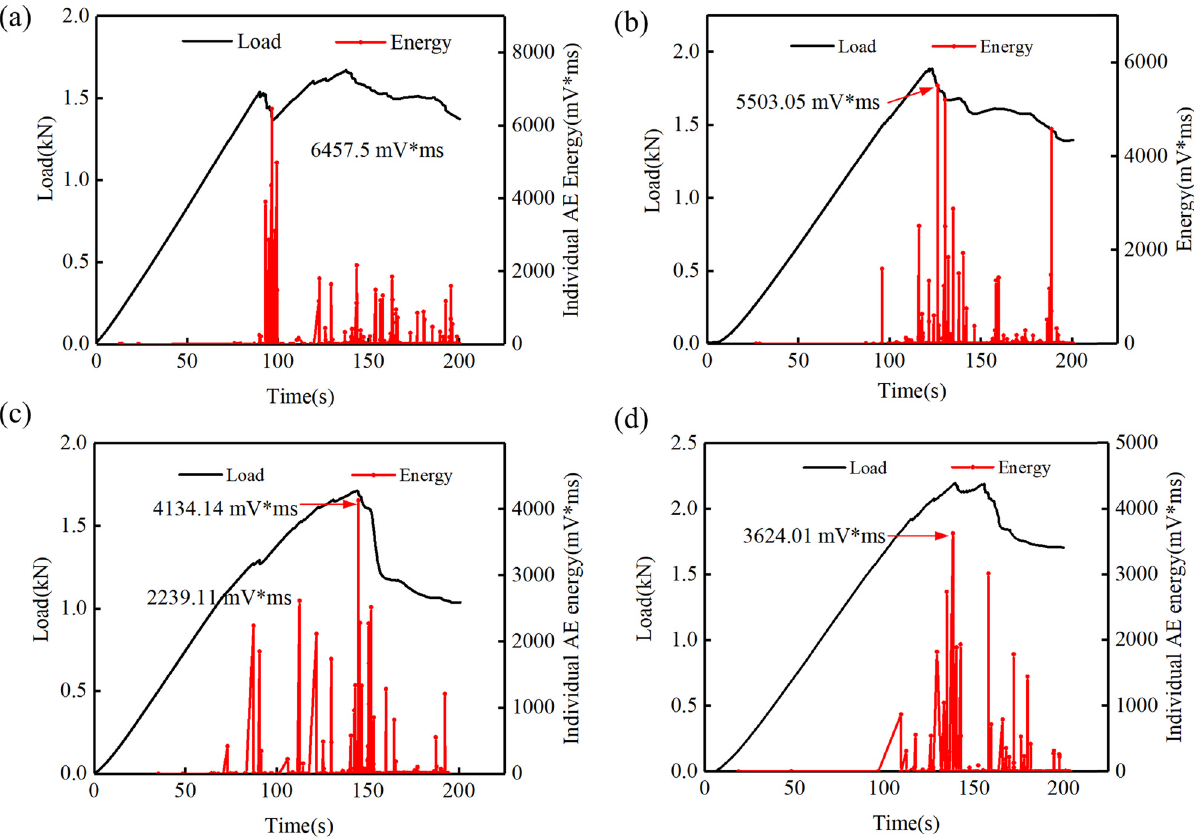
Figure 7: Individual AE energy and load distribution over time. ( a ) – ( d ) Specimens A –